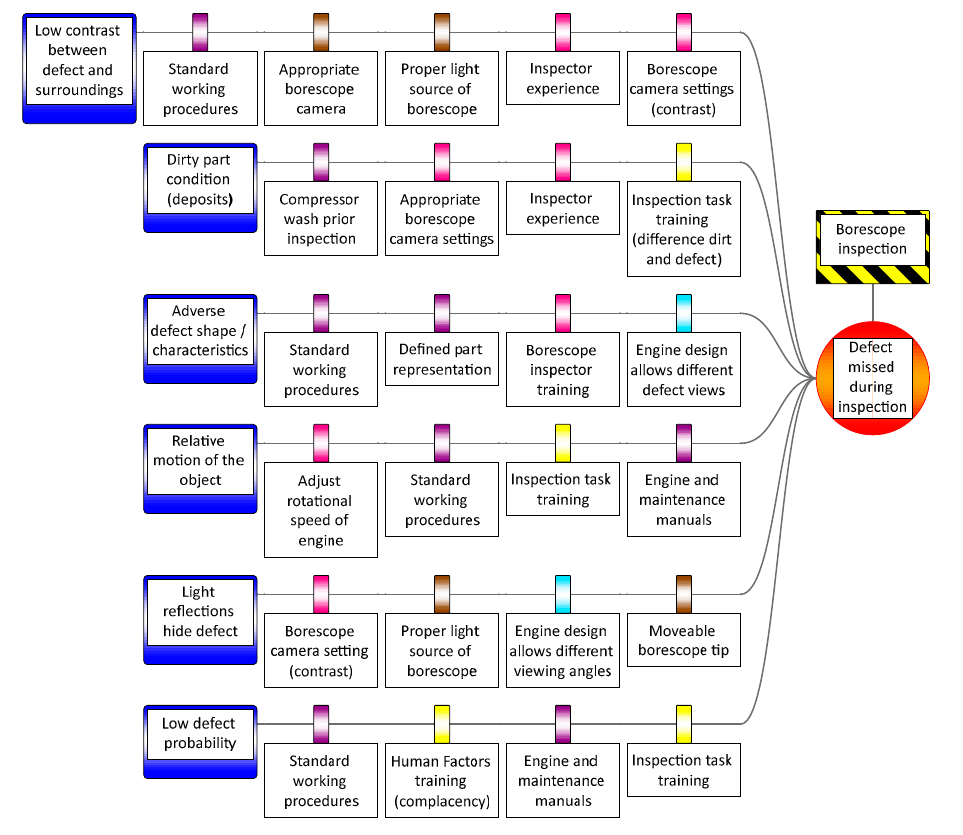
Figure 14. Material-related threat paths with barriers.